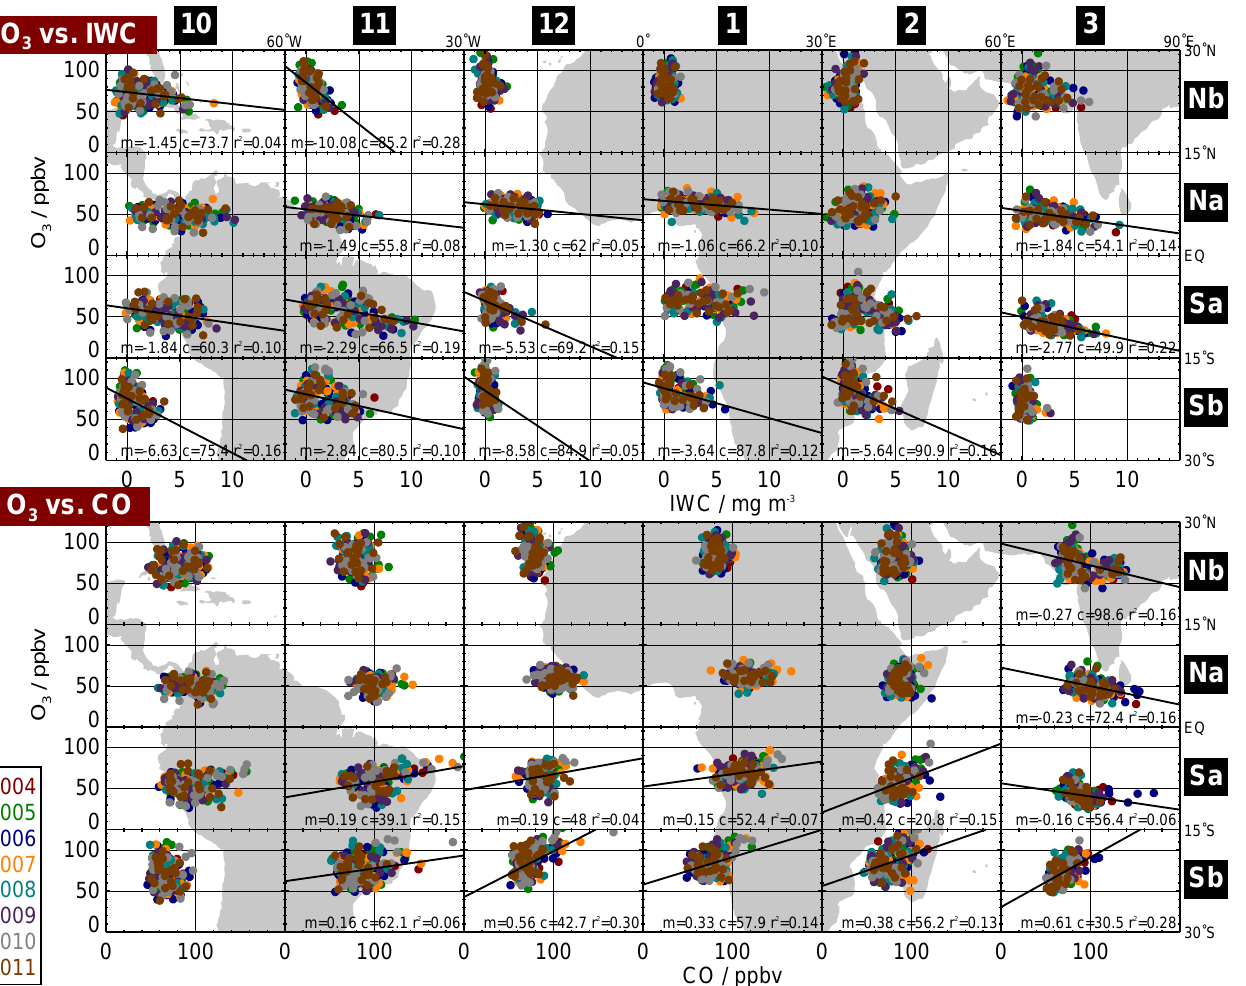
Fig. 6. Scatter plots of the biweekly averages from 90 ◦ W to 90 ◦ E, in Fig. 1, correlating 215hPa MLS O 3 with IWC (upper) CO (lower). Color denotes year, as in Fig. 1. Where statistically significant correlation is found (against a two-tailed t-test at 99% significance), the linear fit line is shown and the r 2 correlation coefficient, gradient ( m , in ppbv/mgm − 3 for O 3 vs. IWC and ppbv/ppbv for O 3 vs. CO) and intercept ( c , in ppbv) are